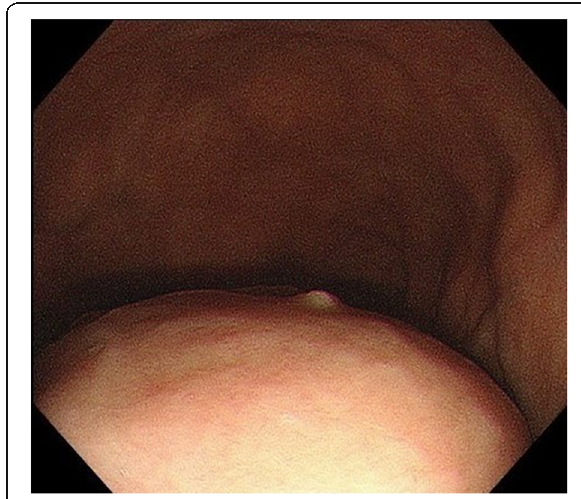
Fig. 2 Esophagogastroscopy showing a huge, hard, elastic, submucosal tumor that extends from the lower esophagus to the gastric